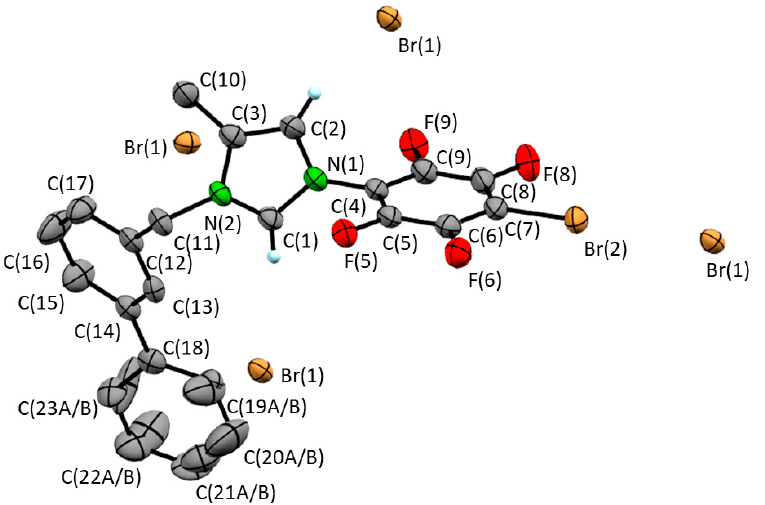
Figure 4. Structure of the cation of salt 3 indicating the positions of the four closest bromide anions. Thermal ellipsoids are at the 50% level. Hydrogen atoms, except those involved in hydrogen bonding, are omitted for clarity.